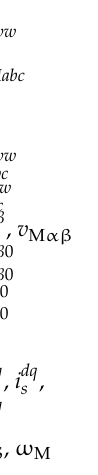
Figure 19. Capacitor voltage waveforms.